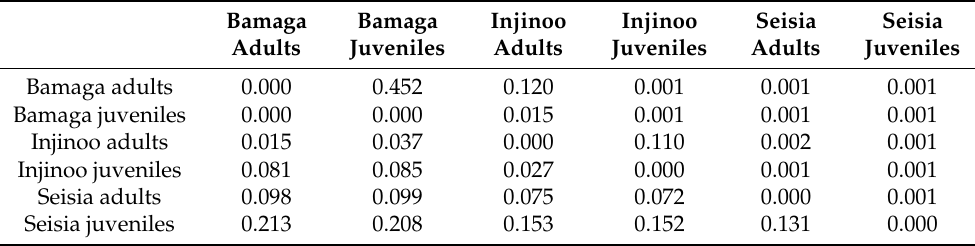
Mean age-class F ST =